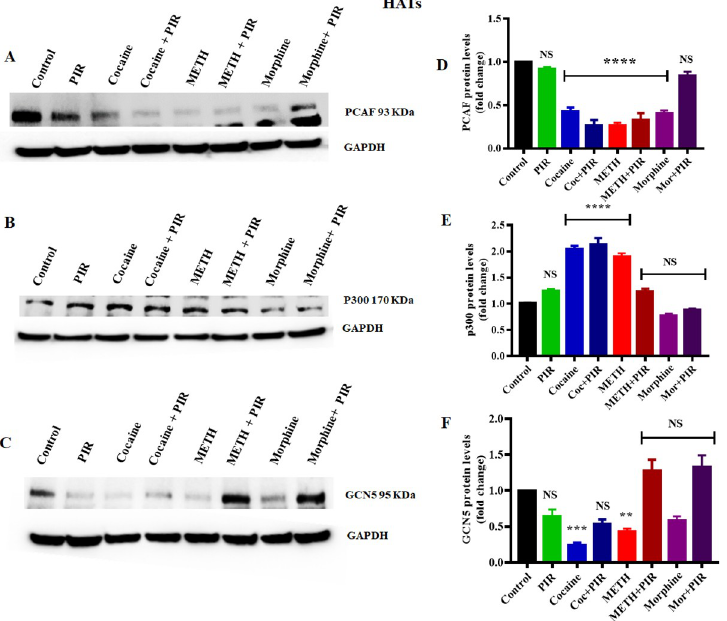
Fig 3. Effects of the psychostimulants cocaine, METH and morphine on HAT proteins in human primary astrocytes. Cells were exposed to cocaine (1 μ M), METH (10 μ M), and morphine (5 μ M) either alone or in combination with piracetam (10 μ M) for 24 h. The protein expression levels of PCAF, p300 and GCN5 in astrocytes were determined by western blotting analysis using GAPDH as a loading control. Two-way ANOVA analysis performed to compare the groups between cocaine Vs cocaine + piracetam, METH Vs METH + piracetam and morphine Vs morphine + piracetam. Western blot showing (A) PCAF, (B) p300 and (C) GCN5. The densitometric analysis results in D, E and F represent the protein levels (fold-change control) of PCAF, p300 and GCN5, respectively. The data are expressed as the mean ± standard error mean of three independent experiments. N = 3. ���� P < 0.0001, ��� P < 0.001, �� P < 0.01,